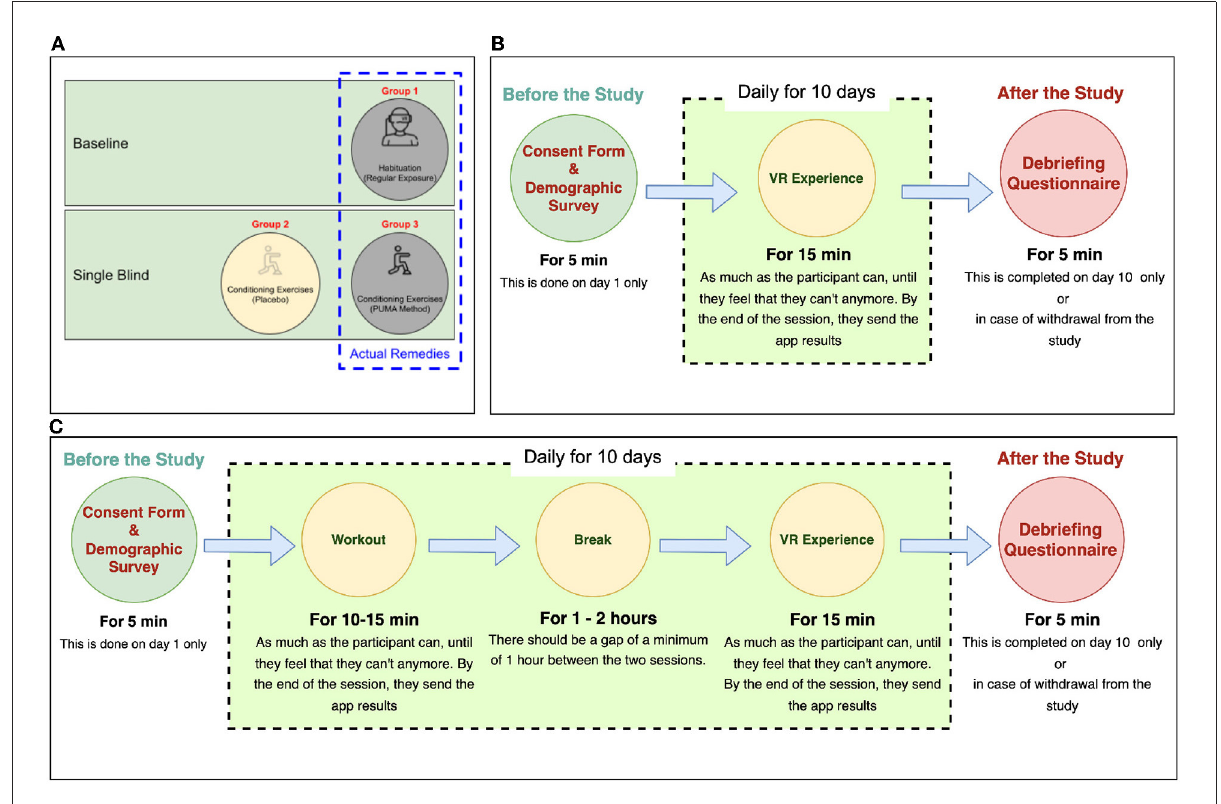
FIGURE7 Visualization of the study design and procedure of the longitudinal cybersickness reduction study. (A) Study design and group distribution. (B) Group 1 study procedure flowchart. (C) Groups 2 and 3 study procedure flowchart.